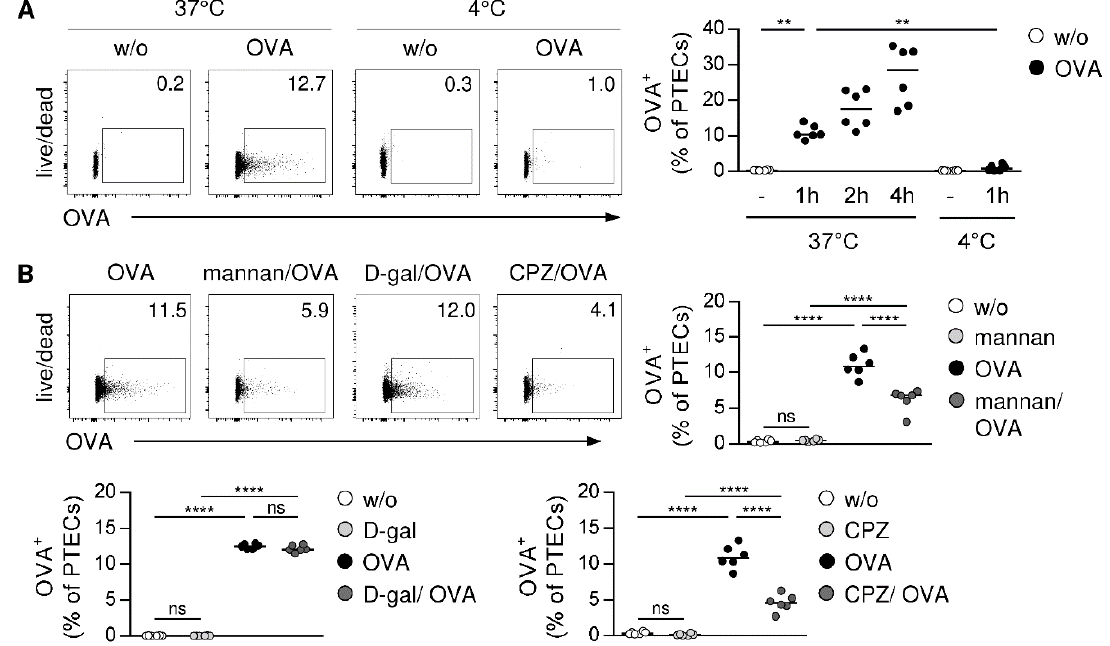
Figure 2. MR-mediated antigen uptake by PTECs. ( A ) PTECs were cultured in presence or absence of fluorochrome-labelled OVA at 37 °C or 4 °C over different periods of time and then analyzed by flow cytometry. ( B ) PTECs were pre-treated with mannan, D-galactose or CPZ before OVA incubation. Representative dot plots and medians of two experiments are shown. ** p < 0.01; **** p < 0.0001; ns: not significant; D-gal: D-galactose; CPZ: chlorpromazine; w/o: without.